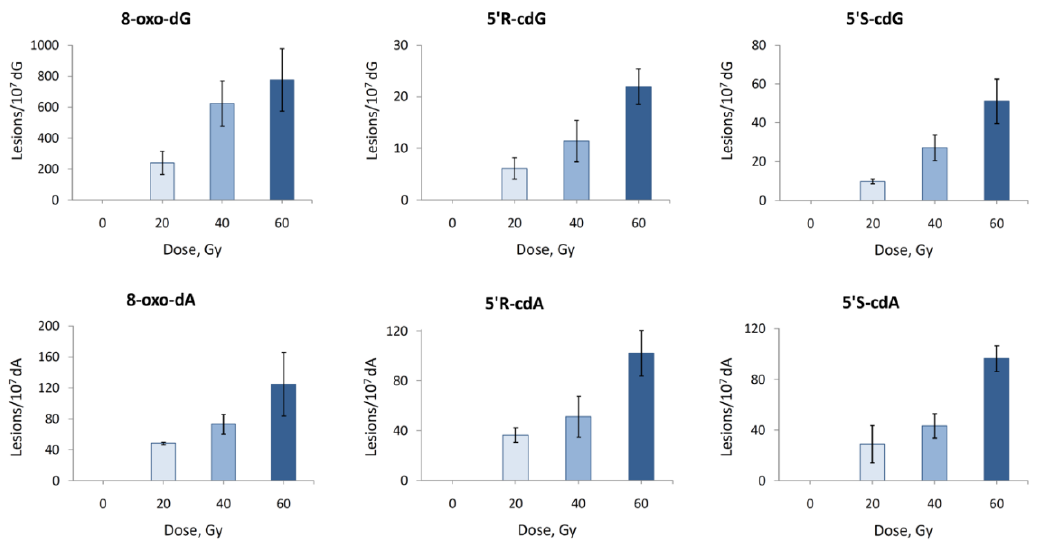
Figure 10. Radiation induced formation of 8-oxo-dG, 5 (cid:48) S -cdG, 5 (cid:48) R -cdG, 8-oxo-dA, 5 (cid:48) S -cdA and 5 (cid:48) R -cdA in double-stranded 21-mer oligonucleotides; Each sample was exposed to 0, 20, 40 and 60 Gy dose in N 2 O-saturated aqueous solutions. The values represent the mean ± SD of n = 3 independent experiments .